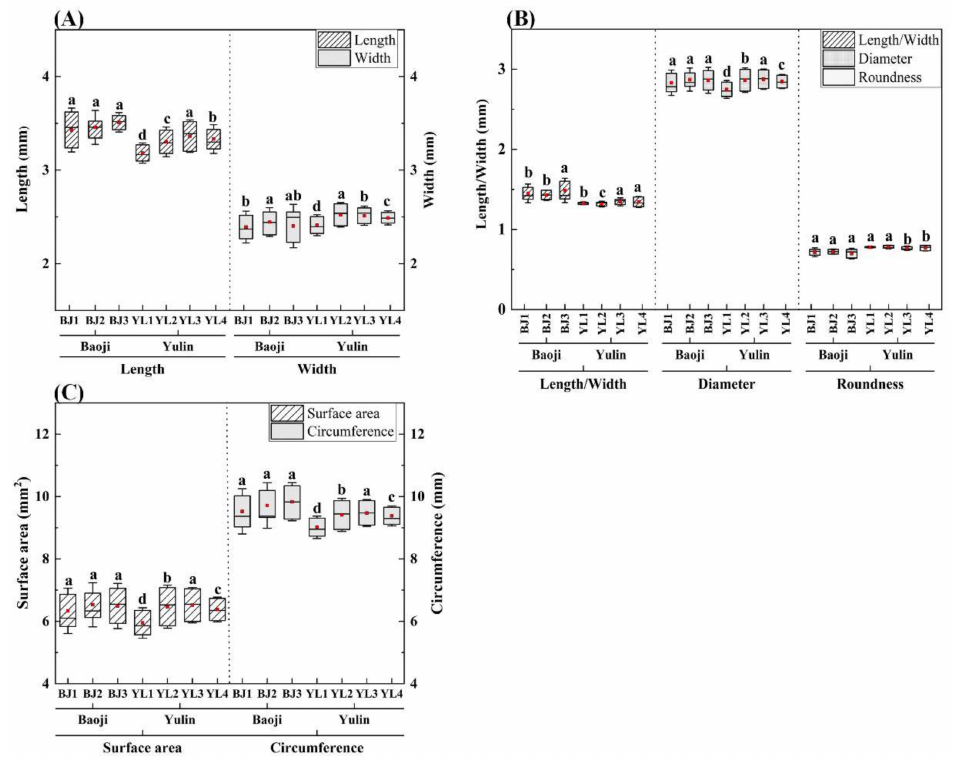
Figure 4. The overall difference in grain size parameters of broomcorn millet ( A , B , C ). Grain length and width were showed in ( A ), grain diameters indexes (length/width, diameter and roundness) were showed in ( B ) and grain surface area and grain circumference were showed in ( C ). BJ and YL represent for sowing date in Baoji and Yulin, respectively; the different lowercases in ( A ), ( B ), and ( C ) represent the significant differences among treatments in each group at two sites.